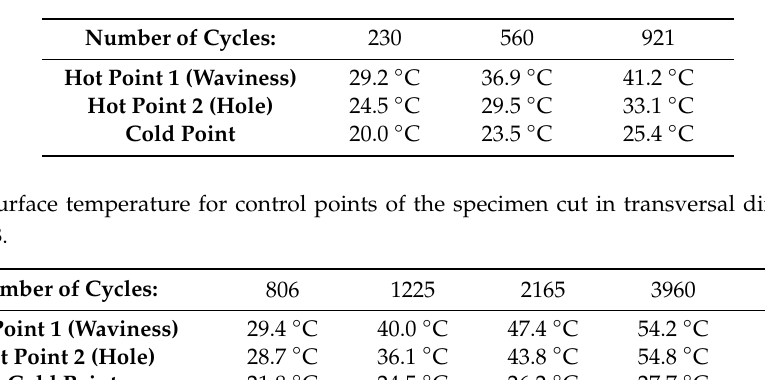
Figure 10. ( a ) Specimen temperature at breakage time for geometry B and ( b ) failure mechanisms observed under optical microscope after breakage.